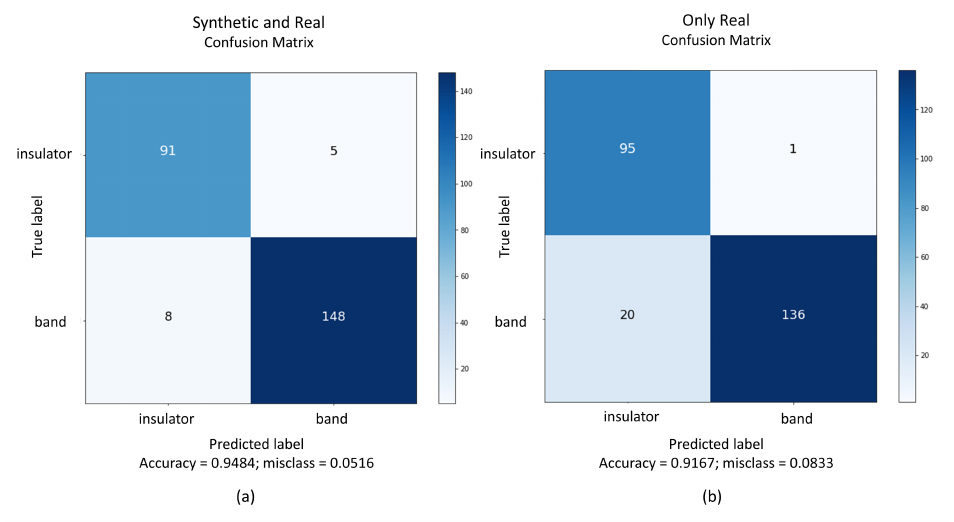
Figure 23. Confusion Matrixes of R-RGB-1 tested on: ( a ) DenseNet trained on S-RGB and R-RGB-2 datasets and ( b ) DenseNet trained on R-RGB-2.